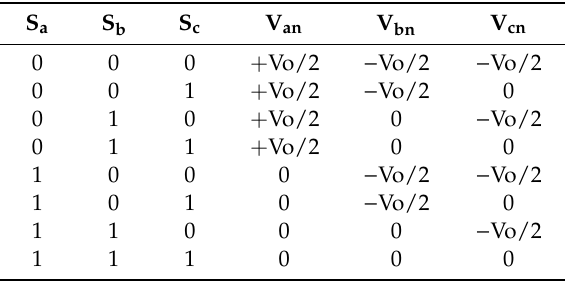
Table 3. Switching conditions for three-phase Vienna